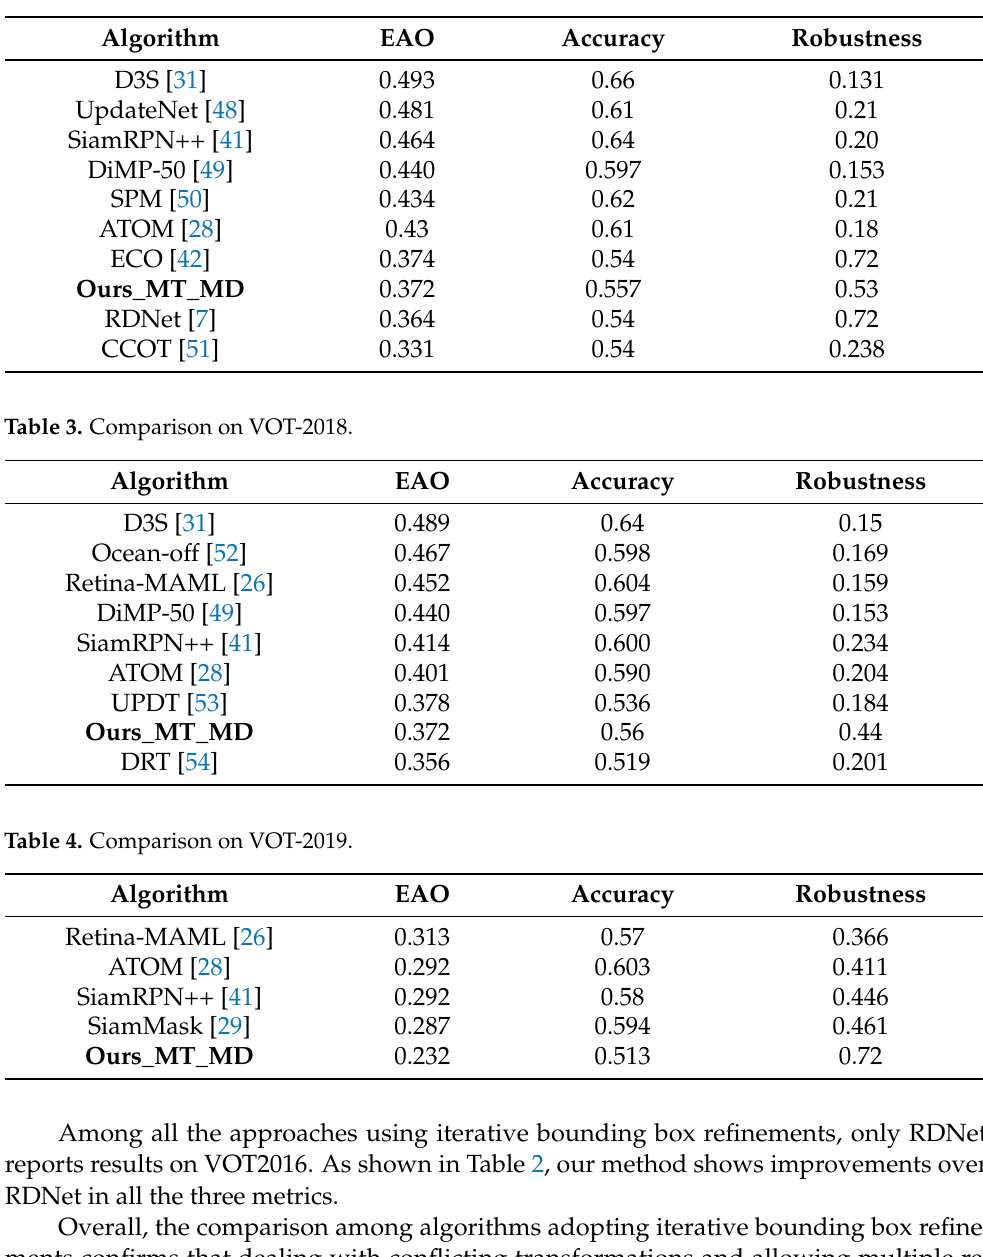
Table 2. Comparison on VOT-2016.